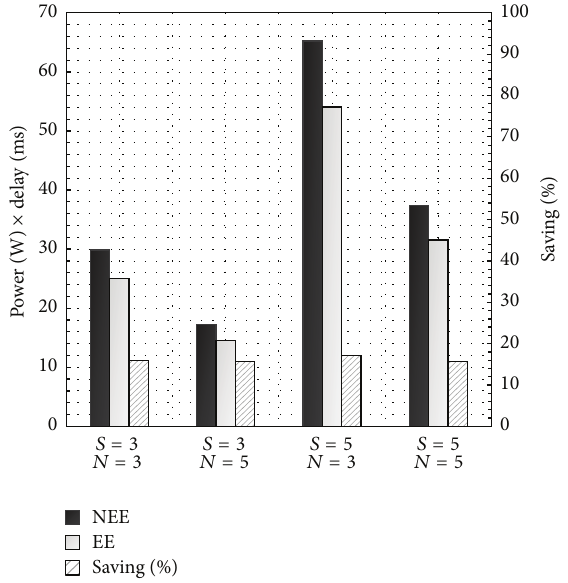
Figure 10: Power consumption and delay product of the various